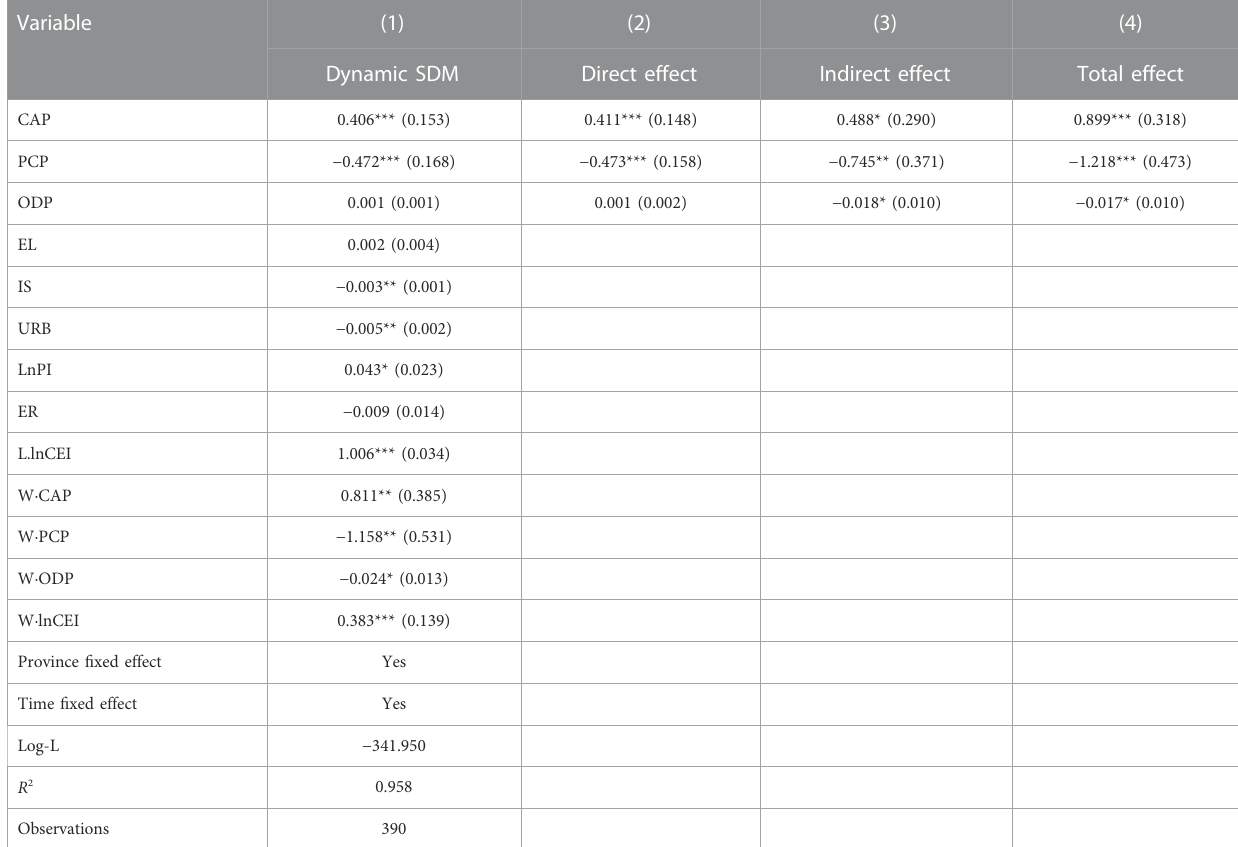
TABLE 7 Impact of EIRT pressure indexes on carbon emission